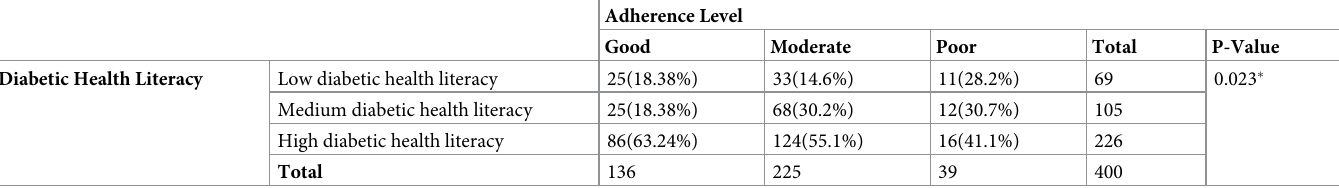
Table 4. Cross-tabulation and Pearson Chi-square test of diabetic health literacy level and adherence of the diabetic patients at the outpatient clinic of UOGCSH, 2019 (N =